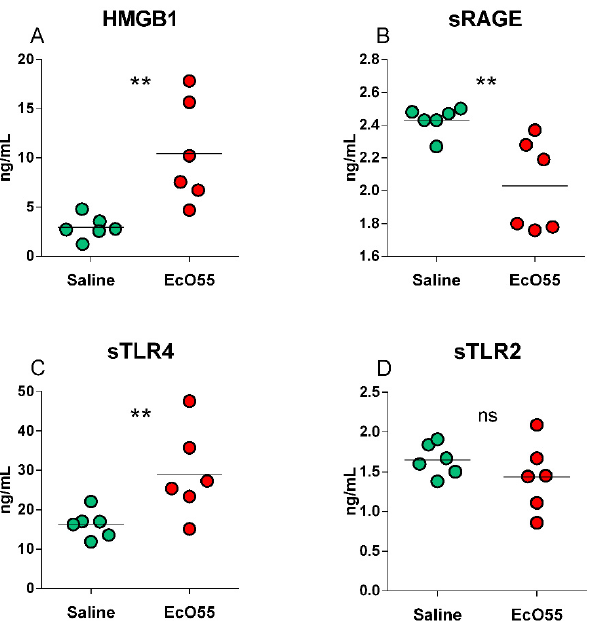
Figure 5. HMGB1, sRAGE, sTLR4, and sTLR2 levels in amniotic fluid. HMGB1 ( A ), sRAGE ( B ), sTLR4 ( C ), and sTLR2 ( D ) in amniotic membrane of sham ‐ infected (saline) and E. coli O55 (EcO55) ‐ infected amniotic cavities. The individual values are depicted as green (saline) or red ( E. coli O55) dots, and the horizontal line represents the mean. Statistical differences were calculated by the un ‐ paired two ‐ tailed Student t ‐ test and labelled as non ‐ significant (ns) or significant p < 0.05 (*), p < 0.01 (**), p < 0.001 (***). Six samples in each group were analyzed.